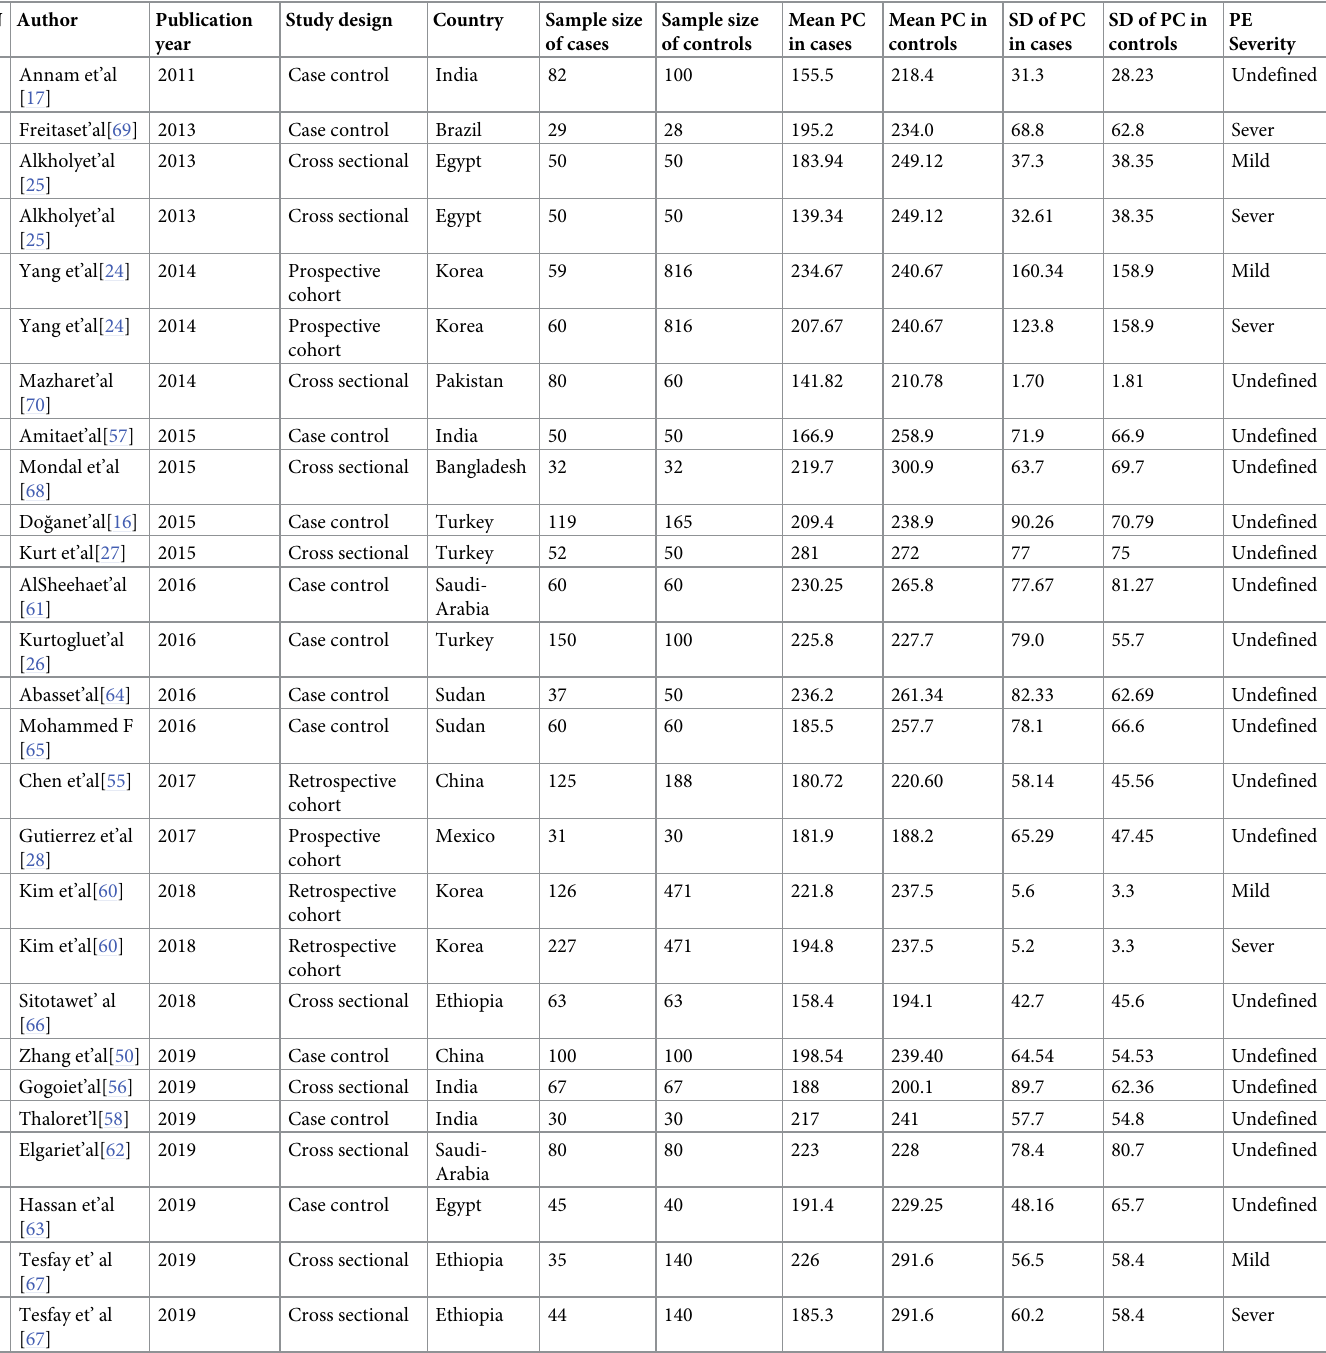
Table 1. Summary characteristics of included studies in the pooled WMD estimate of PC between PE and NT